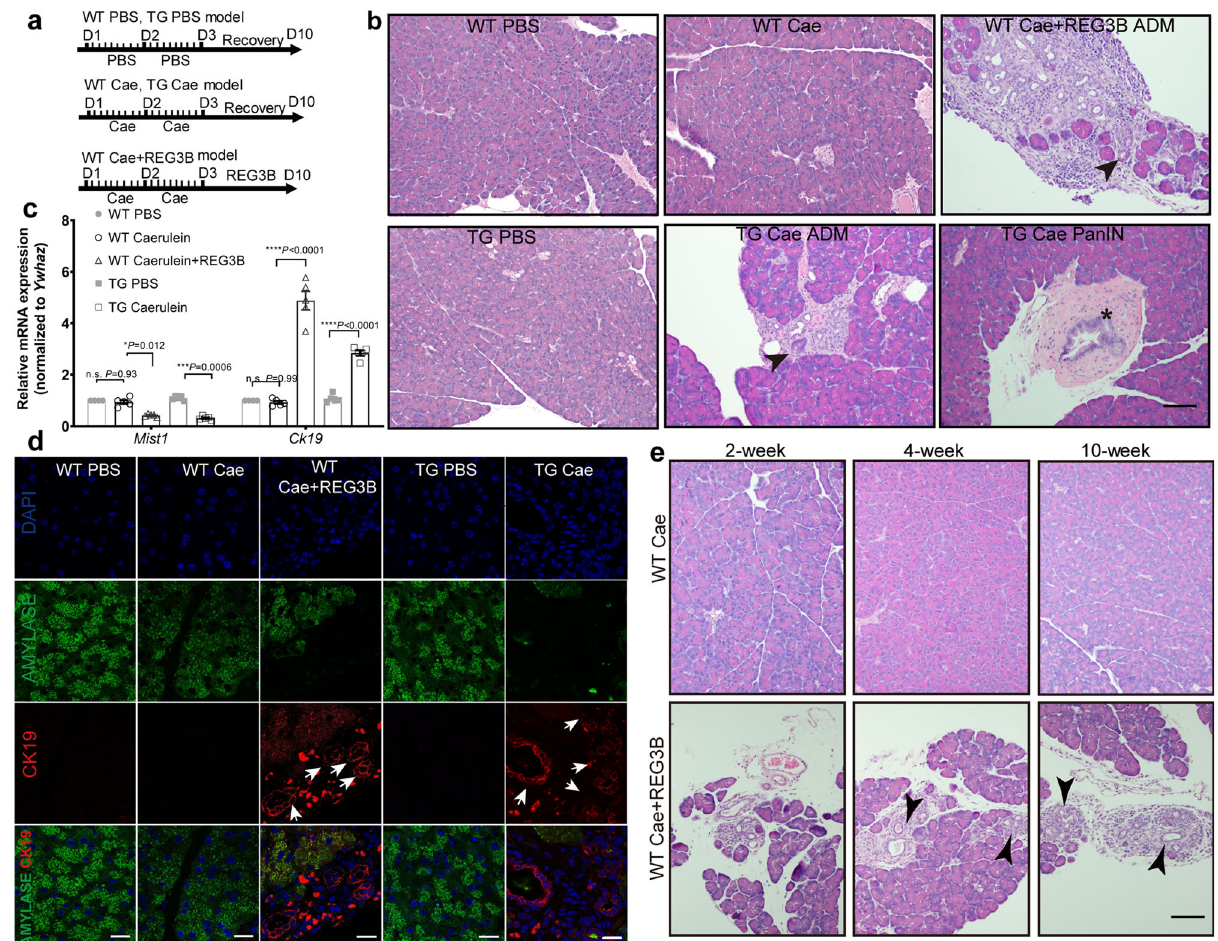
Fig. 3 Enhanced Reg3B maintains prolonged ADM in mice. a Scheme of intraperitoneal injection of different reagents in the fi ve experimental groups. b At day 10 (D10), no ADM phenotype was observed in WT mice injected with caerulein. WT mice injected with both recombinant mouse REG3B protein and caerulein, and the REG3B TG mice injected with caerulein showed persistent ADM as indicated by the ductal morphology (black arrow heads) in H&E staining. Focal PanIN (marked by black asterisk) was observed in two out fi ve REG3B TG mice injected with caerulein. Scale bar: 200 μ m. c WT mice injected with recombinant REG3B and caerulein and the REG3B TG mice injected with caerulein demonstrate higher levels of Ck19 and lower levels of Mist1 mRNA. ( n = 5, one-way ANOVA). d Immuno fl uorescence staining shows gain of CK19 expression (red) and loss of AMYLASE (green) in the ADM area of WT mice injected with recombinant REG3B and caerulein and in the Reg3b TG mice injected with caerulein. Scale bars: 20 μ m. White arrows indicate ADM. e Persistence of ADM in WT mice injected with recombinant REG3B 2, 4, and 10 weeks after caerulein injection. ( n = 5, magni fi cation ×200, scale bar: 200 μ m). Values in graphs are means ± SD, * P < 0.05; ** P < 0.01; *** P < 0.001. Non-signi fi cant (n.s.) if P > 0.05. n = 5 per group, WT wild type, TG REG3B transgenic mice, Cae